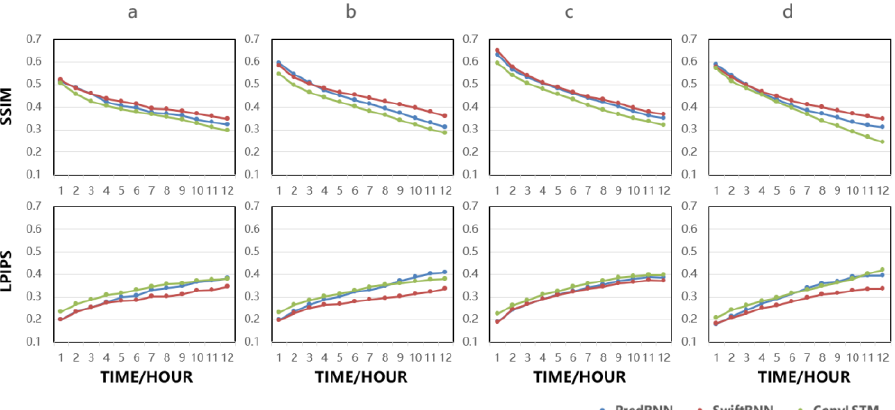
Figure 7. Image similarity metrics for visibility field map prediction in ( a ) January, ( b ) April, ( c ) July, and ( d )